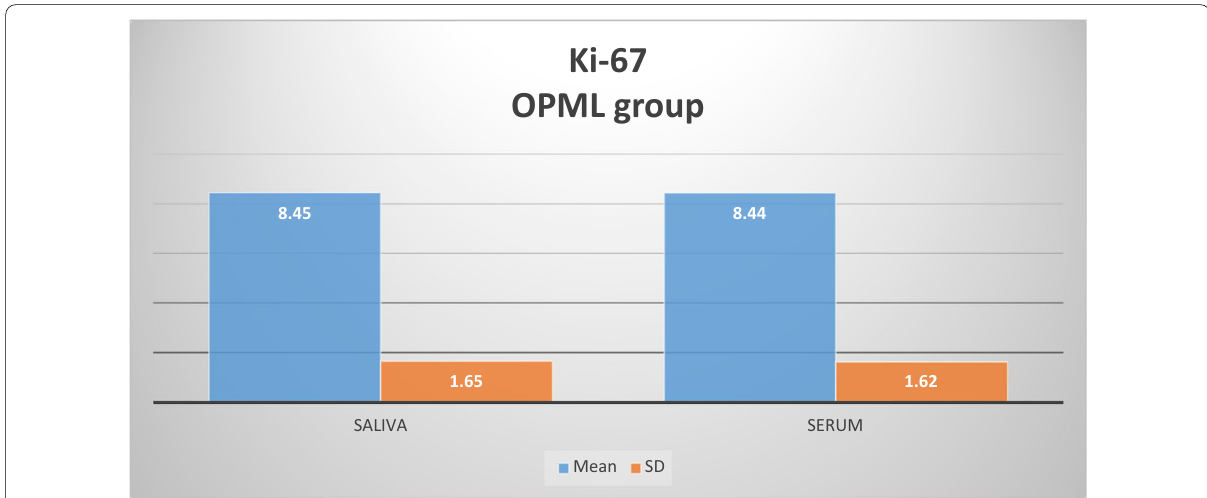
Fig. 11 Bar chart showing mean and standard deviation of Ki-67 in saliva and serum in OPML